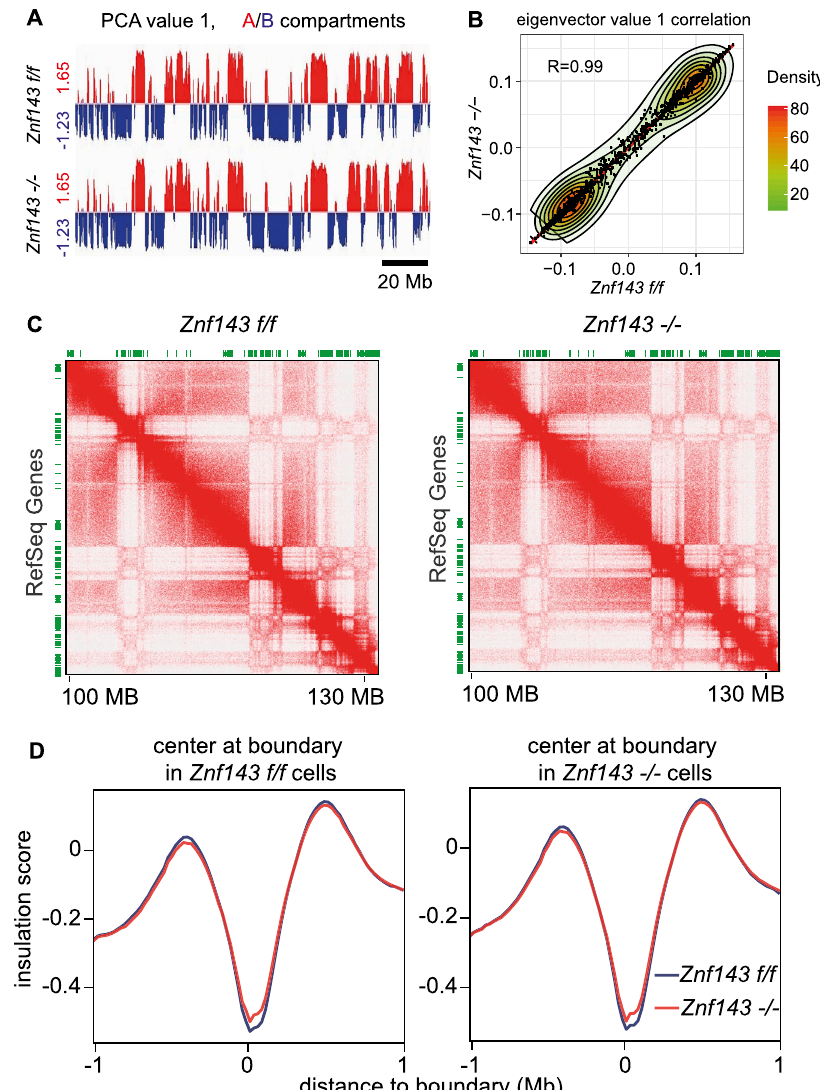
Fig. 3 Chromosome compartments and TADs mainly remain unchanged after Znf143 deletion. a PCA analysis for the fi rst principle component representing compartment A and B on chr1 at 50 kb resolution. b Density plot describes global correlation between the eigenvector value from wild type ( Znf143 f/f ) and Znf143 depleted ( Znf143 − / − ) LSKs at 1 Mb resolution. The X -axis represents the eigenvector value in Znf143 f/f cells on each genome locus, while the Y -axis the value in Znf143 − / − cells in the same locus. c Comparison of TADs in wild type ( Znf143 f/f ) and Znf143 knockout ( Znf143 − / − ) cells. A snapshot of balanced contact matrices on chr1:100 – 130 Mb. d Mean plot describes genome-wide insulation score around TADs boundaries. The X - axis represents the genome distance to the TADs boundaries, while the Y -axis the insulation score. The 0 position on the X -axis in the left panel indicates TAD boundaries in Znf143 f/f cells, while in the right panel TAD boundaries in Znf143 − / −